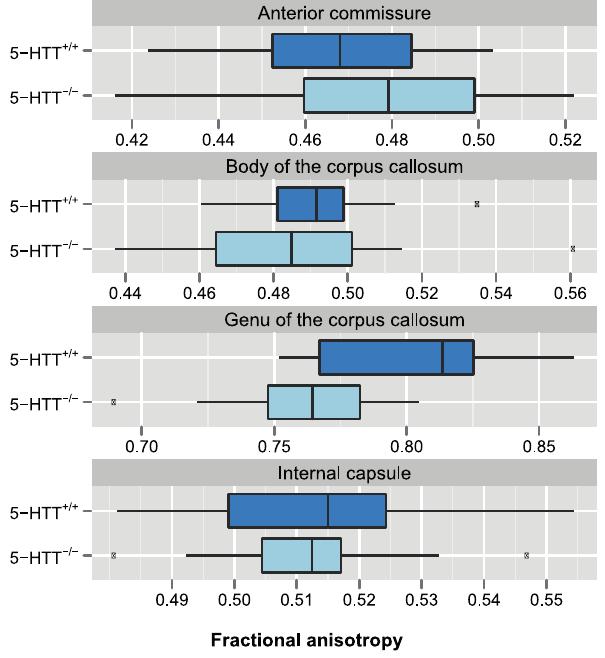
Figure 6. White matter fractional anisotropy values from seed- based analysis of fractional anisotropy maps. DTI fractional anisotropy was measured in four different white matter seed regions. Boxplots display for 5-HTT -/- and 5-HTT + / + animals the average value in each of the regions. Fractional anisotropy was significantly lower in the genu of the corpus callosum of 5-HTT -/- animals (two-sample t -test, t = -3.33, false discovery rate (FDR)-adjusted p , 0.05).